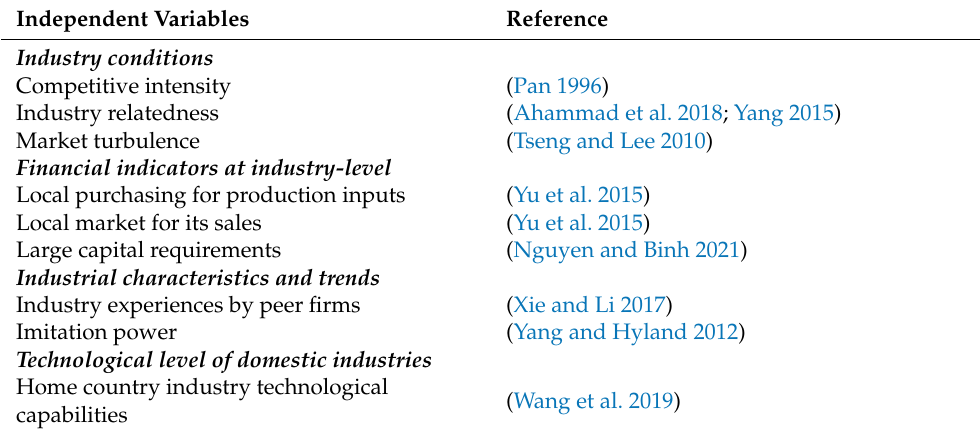
Table 4. Industry-level environmental volatility factors that affect EMNEs’ entry mode